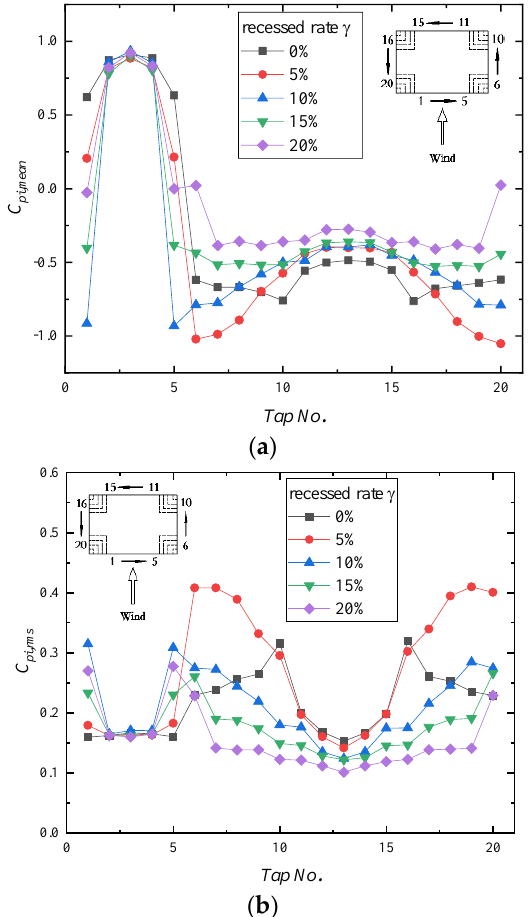
Figure 7. The comparisons of wind pressure coefficients at the height of 2/3H for corner set-back models. ( a ) Mean wind pressure coefficients at the height of 2/3H for models. ( b ) RMS wind pressure coefficients at the height of 2/3H for models.